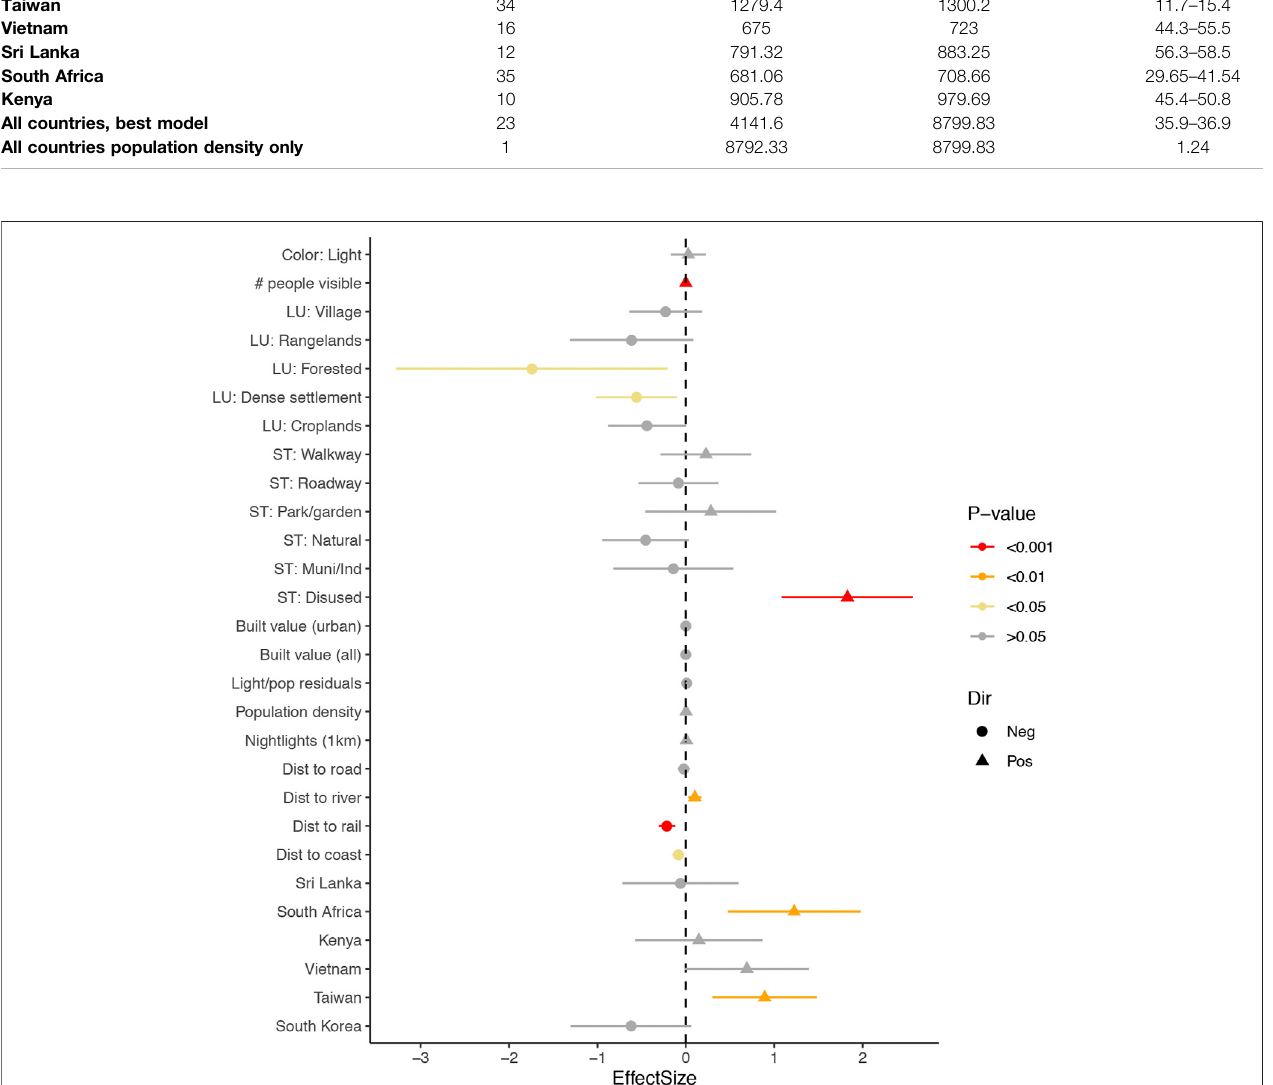
FIGURE1| Effectsizeplotsforallcountriestogether.Colorrepresentsthe p -valuesigni fi cancelevel,andthelinesarethestandarderrorforeachterm.Trianglesdenote a positive coef fi cient for a given factor, whereas circles denote a negative coef fi cient. The effect size is calculated as the median value of the factor times its coef fi cient.